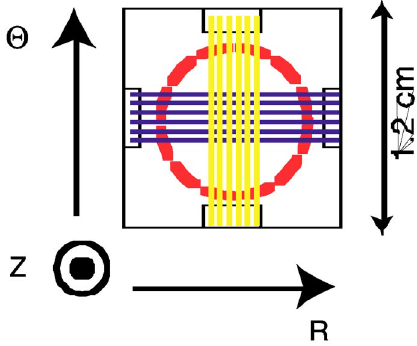
FIG. 20. (Color) Illustration of the orientation of the windings on the magnetic-field probe. All windings have circular cross sections and consist of two layers.